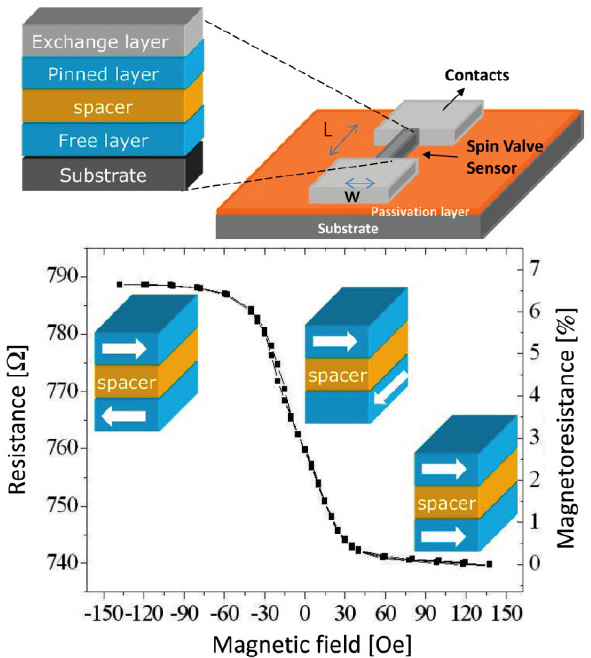
Figure 2. Resistance vs . magnetic field transfer curve of a linear spin-valve at a given sense